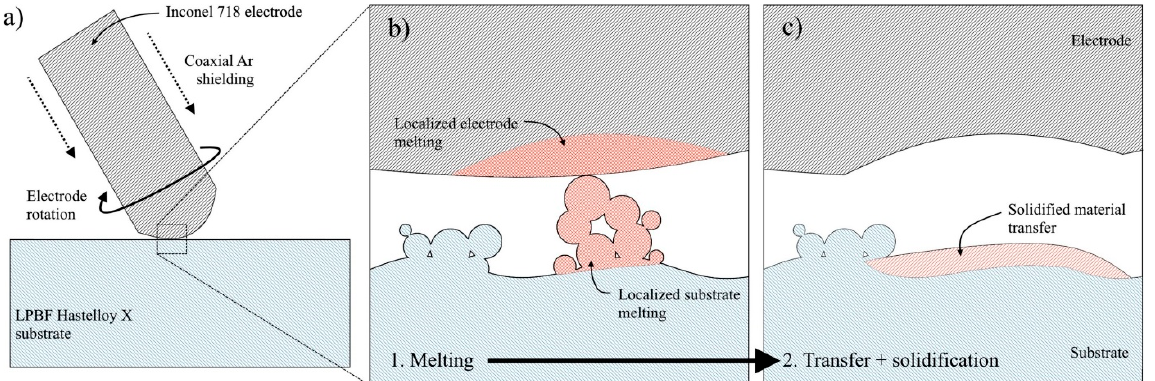
Figure 7. Simplified schematic of the ESD process showing: ( a ) overview of electrode and substrate; ( b ) localized melting of electrode and substrate during ESD; and ( c ) material transfer and solidification (Reproduced from [135] with permission from Elsevier).